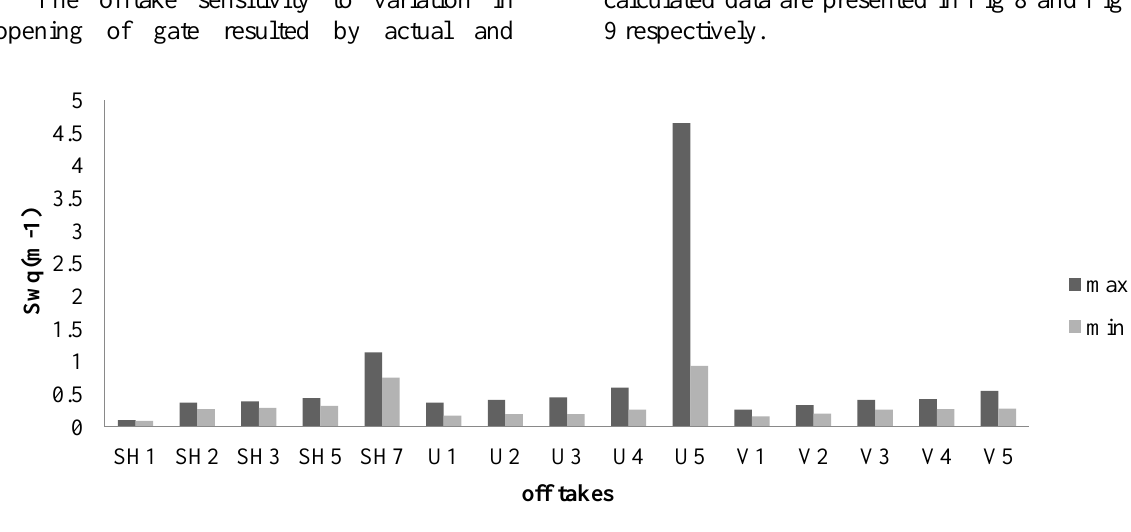
Fig. 8 Offtake sensitivity of delivery to gate opening Index (Real Data)